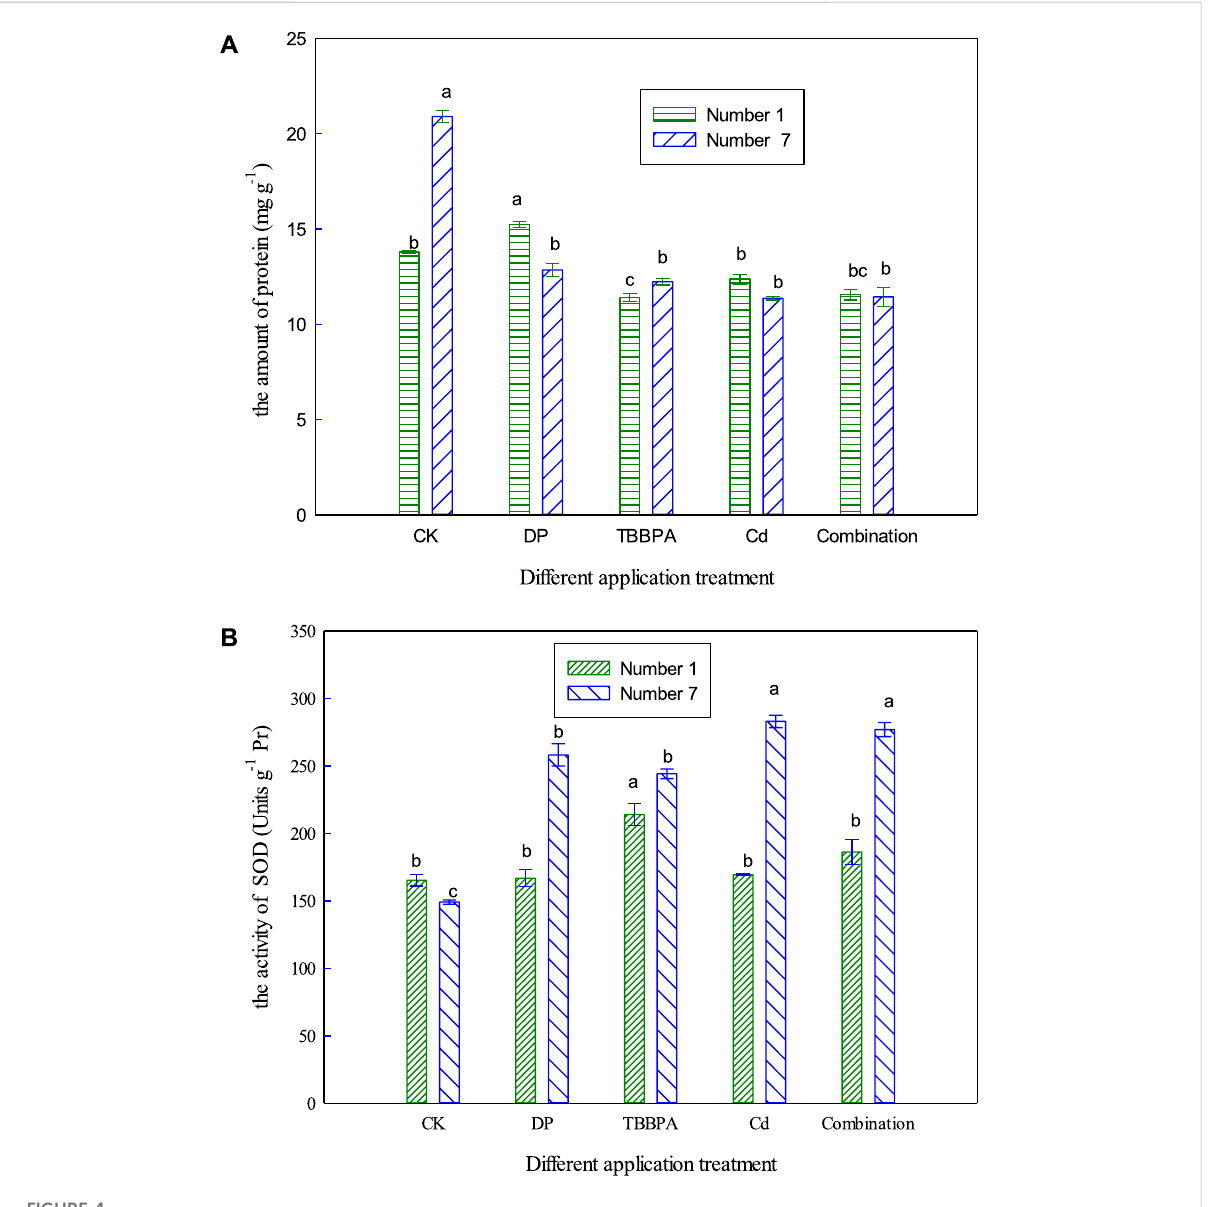
FIGURE 4 Phytotoxicity of two halogenated fl ame retardants and cadmium in the soil on the seedlings of two rice varieties. (A) The amount of protein (mg · g -1 ) of two rice varieties in different application treatments. (B) The activity of SOD (Units · g -1 Pr) of two rice varieties in different application treatments. (C) TheactivityofCAT(Units · mg -1 Pr)oftworicevarietiesindifferentapplicationtreatments. (D) TheactivityofPOD(U · g -1 · min -1 Pr)oftwo rice varieties in different application treatments. (E) The amount of MDA ( μ mol · g -1 Pr) of two rice varieties in different application treatments. (F) The amount of Chlorophyll a ( μ g · g -1 ) of two rice varieties in different application treatments. (G) The amount of Chlorophyll b ( μ g · g -1 ) of two rice varieties in different application treatments. (H) The amount of Chlorophyll ( μ g · g -1 ) of two rice varieties in different application